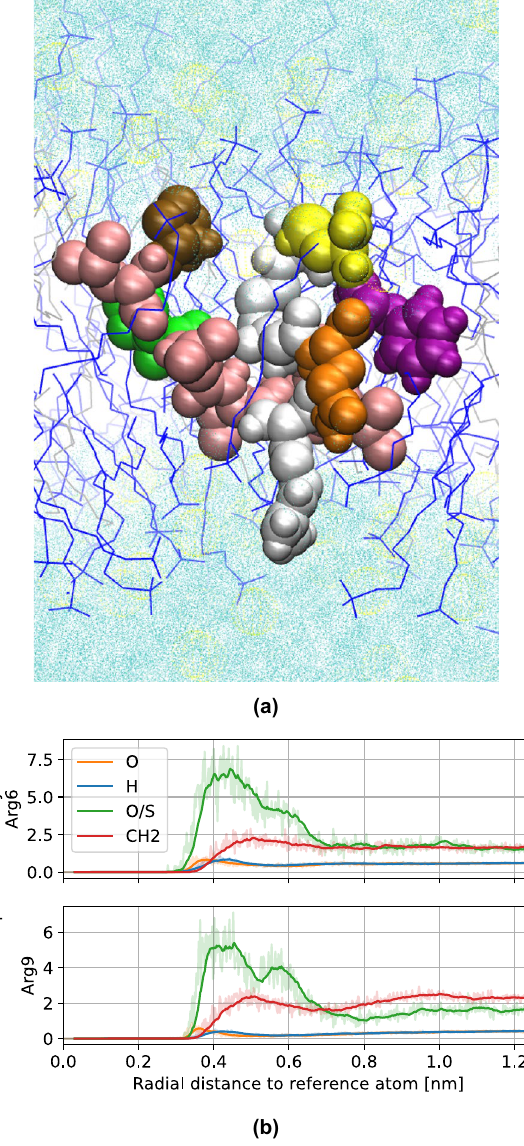
Figure 8. ( a ) Single frame of the TP1 peptide at the first step of the potential stair , 0.72 nm away from the bilayer center. ( b ) Radial distribution functions of arginine fragments of the peptide at this